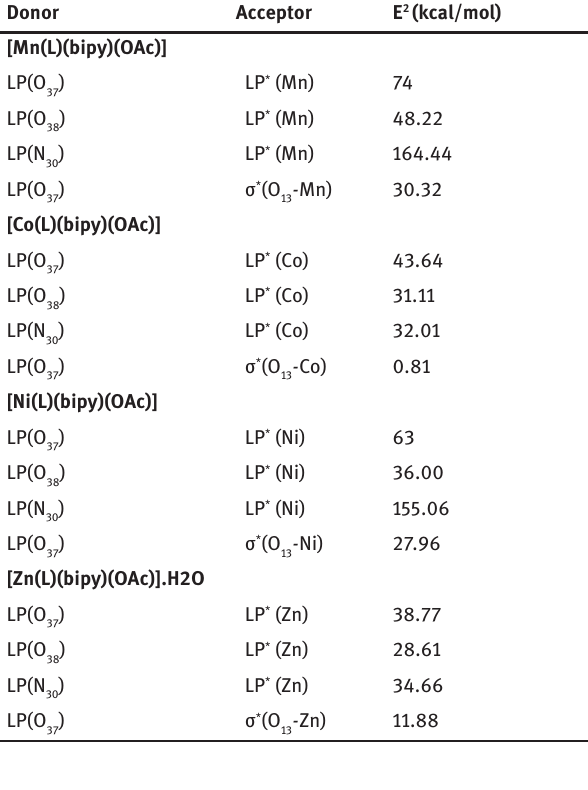
Table 3 : Second-order perturbation stabilization energies corresponding to the major intermolecular charge transfer interaction (Donor-Acceptor) of ligand-metal complexes obtained B3LYP/ 6-31+G(d,p)+LANL2DZ.